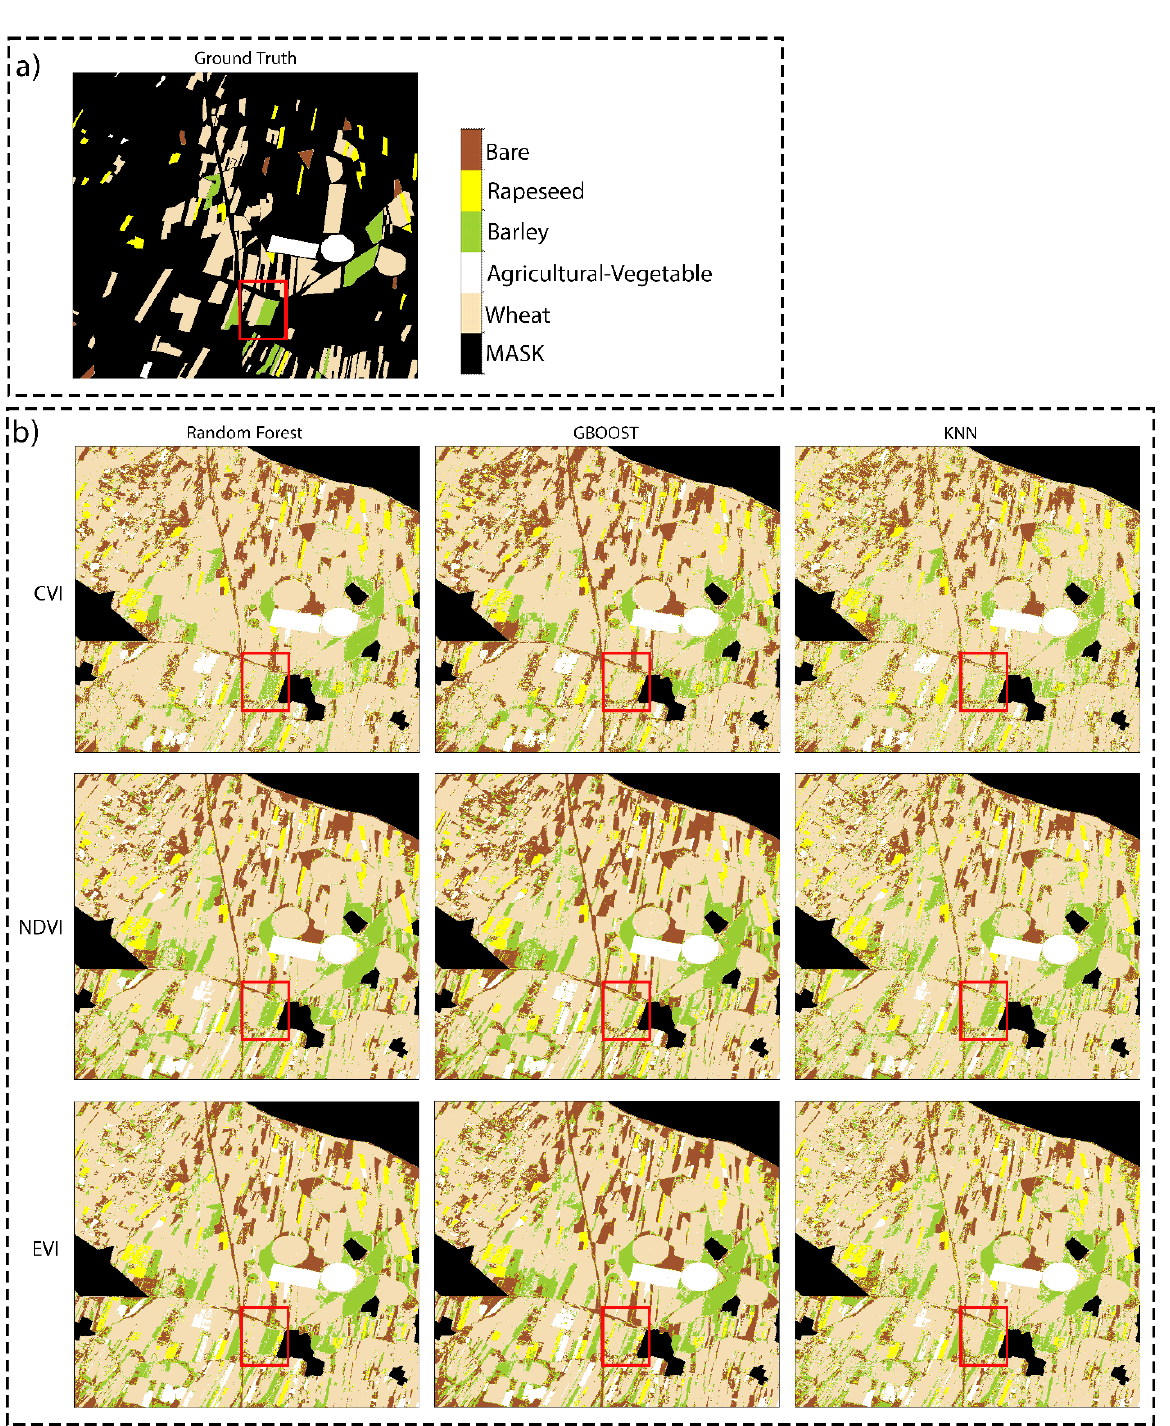
Figure 3 . Comparison of the result of crop mapping using three algorithms (RF, GB, KNN) with CVI, NDVI, and EVI inputs. The red boxes indicate the same locations to further visual analysis. a) Collected in-situ data as ground truth, b) crop maps produced using ML methods and